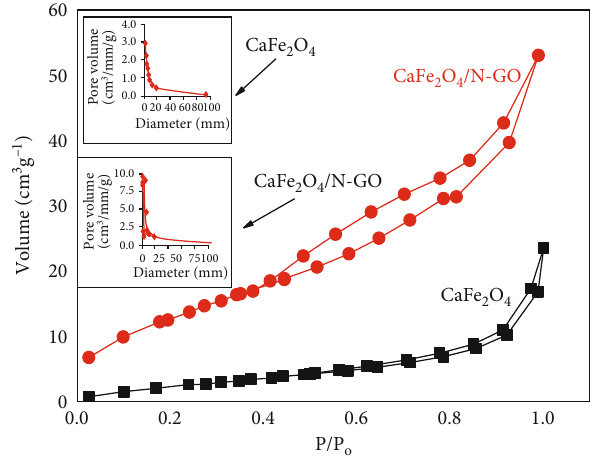
Figure 4: Magnetization curve of the synthesized CaFe separation of magnetic nanocomposite after dye removal) (a) and TGA curve of CaFe nanocomposite (b).